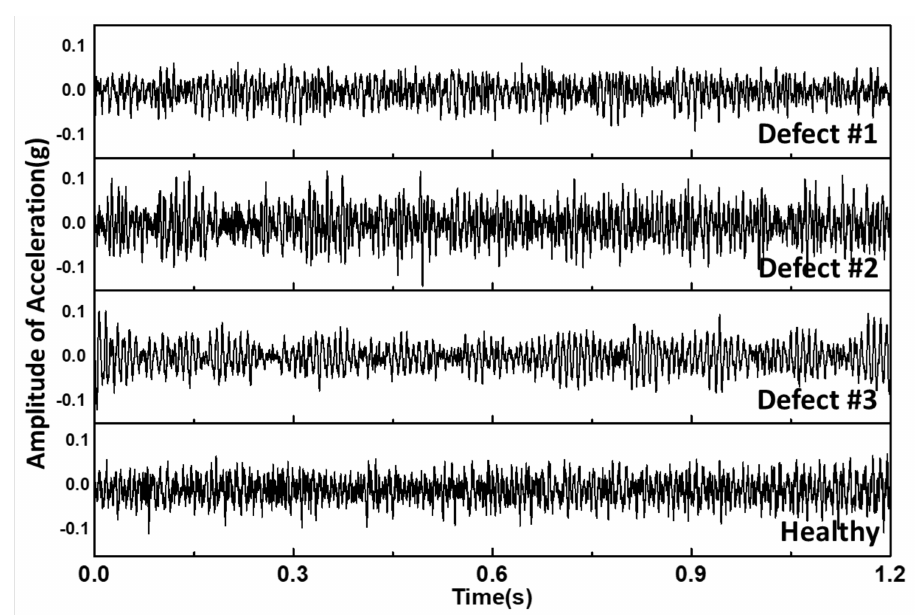
Figure 4. Read-out of vibration signals collected by the SmartCheck system. Defects #1–#3 represent the “notched” drill bit, the drill bit with a “blunt edge”, and the drill bit with a “blunt head”, respectively. “Healthy” represents a drill bit without any